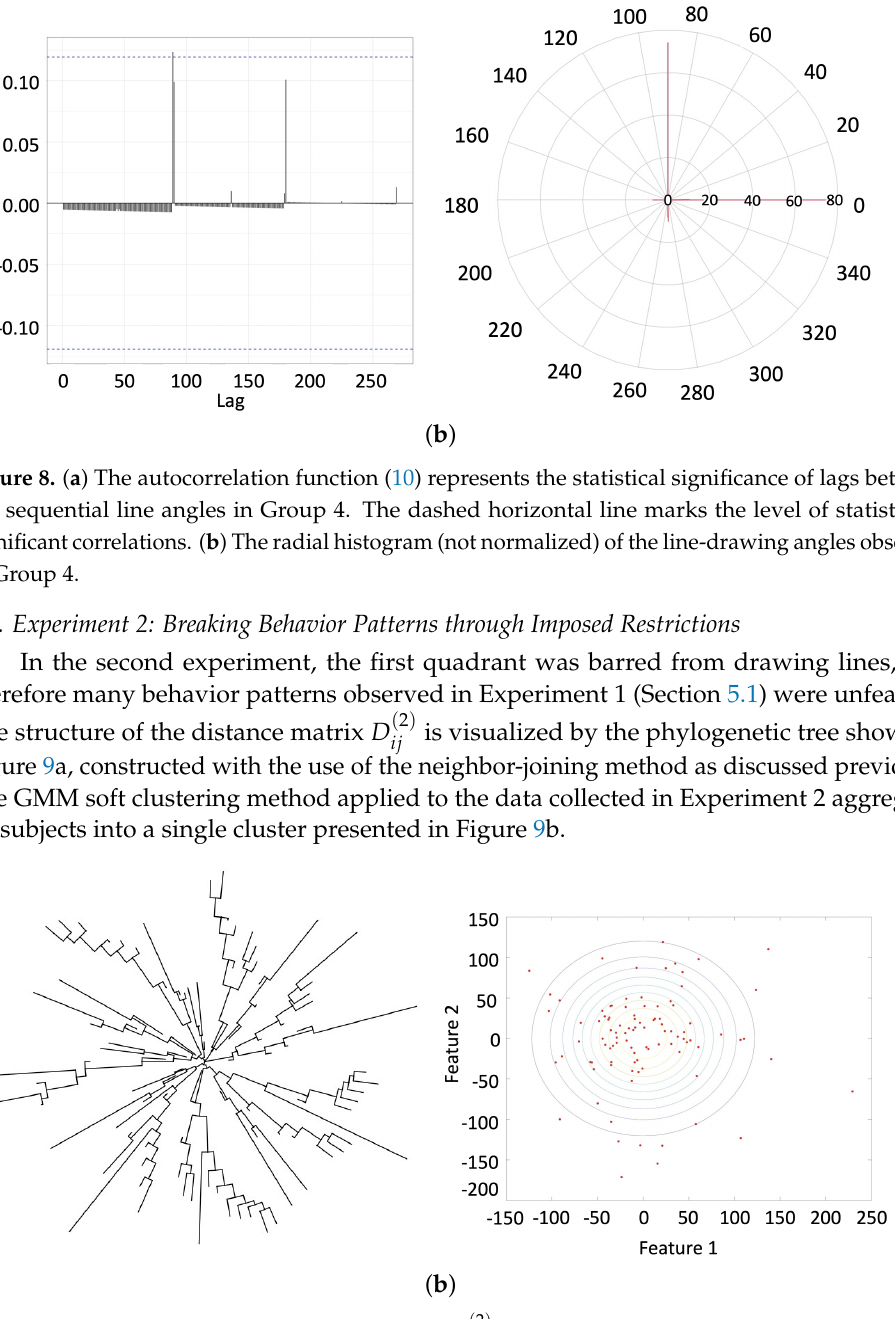
( 2 ) Figure 9. ( a ) The structure of the distance matrix D visualized by a phylogenetic tree with the use ij of the neighbor-joining method. ( b ) The results of GMM clustering aggregates all participants of Experiment 2 into a single cluster. Features 1 and 2 (the coordinates obtained for subjects when the iteration process converged) are measured in procedure-defined